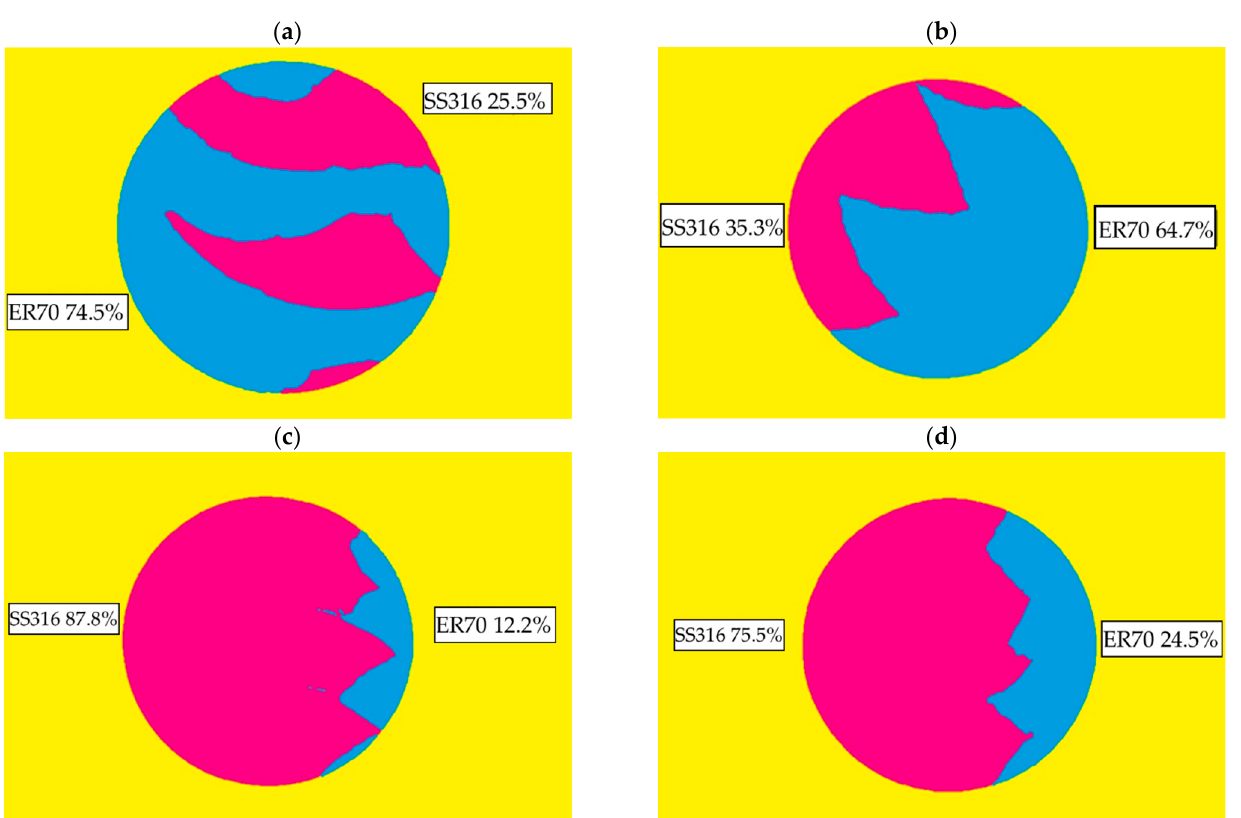
Figure 10. Cross-section material determination in ( a ) Sample 1, ( b ) Sample 2, ( c ) Sample 3 and ( d ) Sample 4.